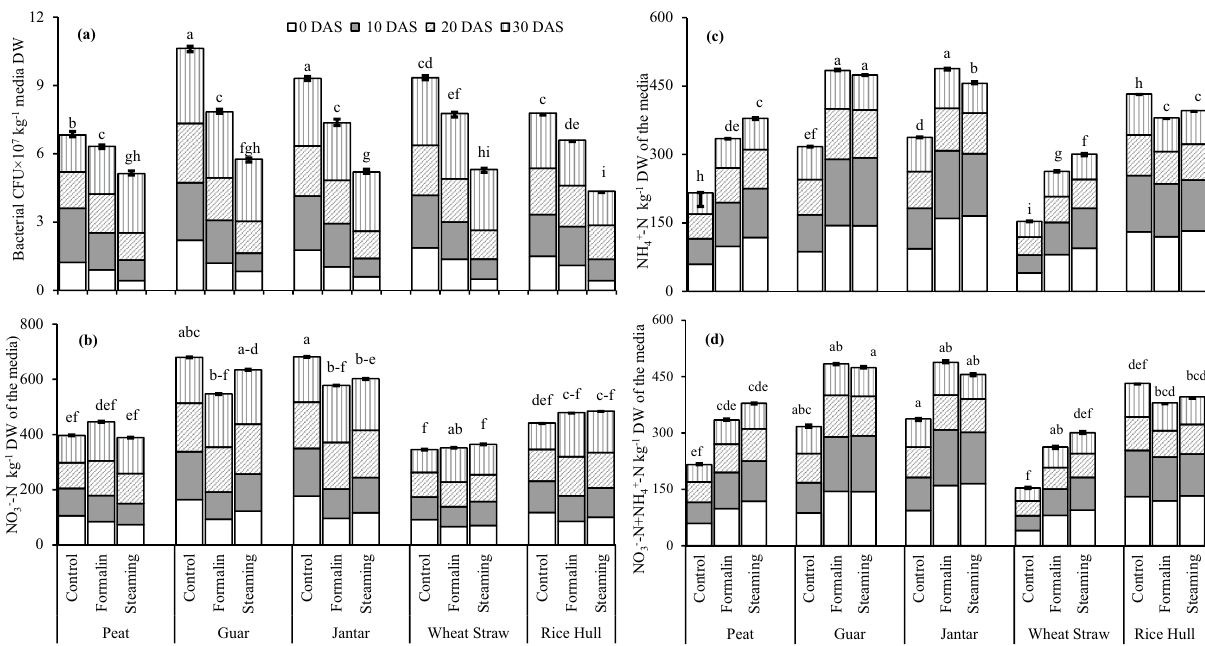
Figure 2. Effect of sanitized media on: ( a ) relative abundance of nitrifying bacteria over the time, ( b ) NO 3 − –N mg kg −1 media, ( c ) NH 4 + –N mg kg −1 media and ( d ) NO 3 − –N + NH 4 + –N mg kg −1 media over the time. All the values are means ± S.E of three replicates, whereas case letters indicate significant differences among the treatments at p ≤ 0.05 level. All the composts used in greenhouse experiment were established at 10% AFP. DAS = Days were after